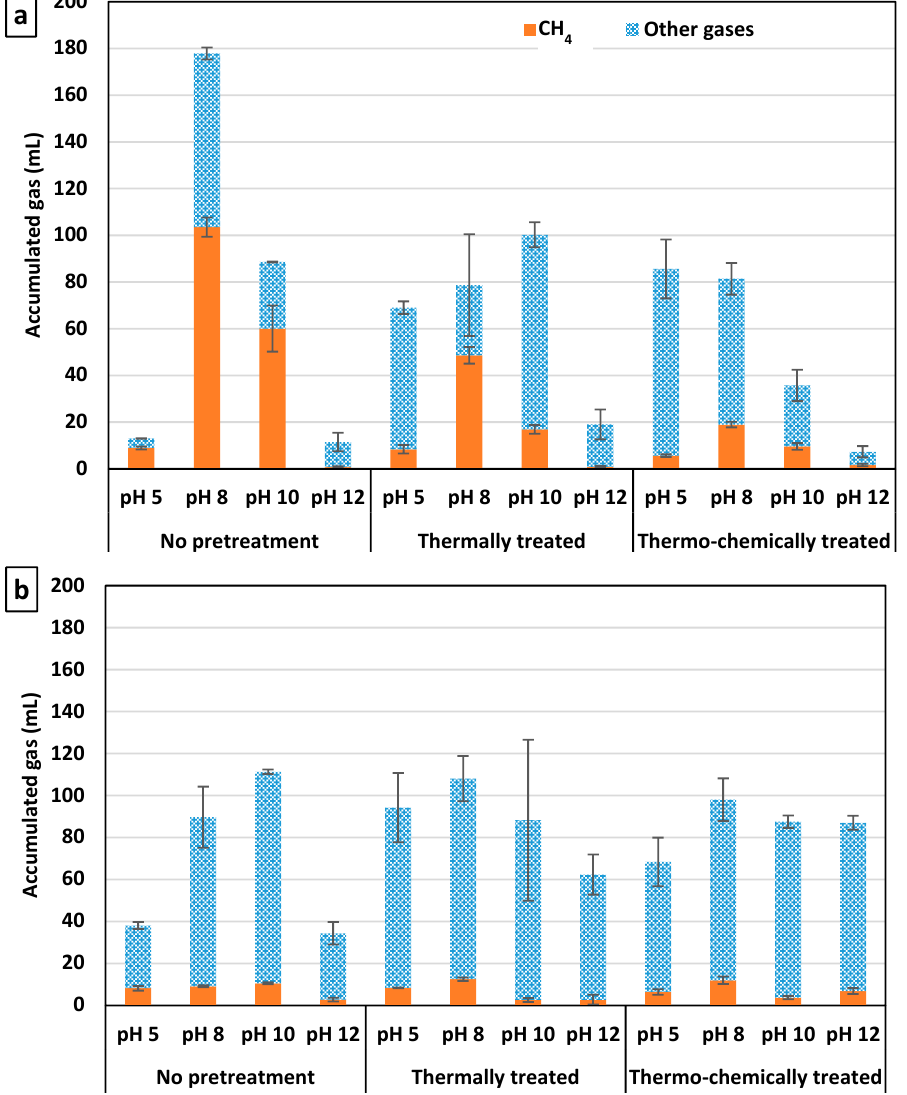
Figure 9. Biogas production from ( a ) excess sewage sludge and ( b ) food waste slurry in batch reactors for the different treatment methods at different pH levels.